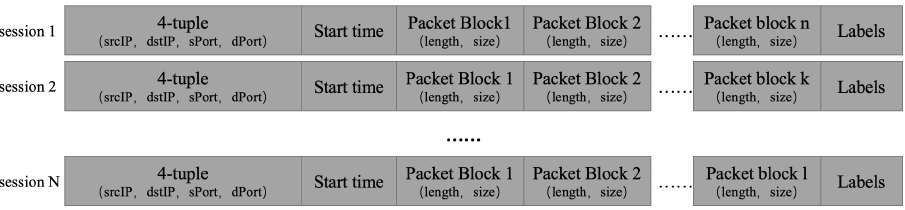
Figure 5. Example of